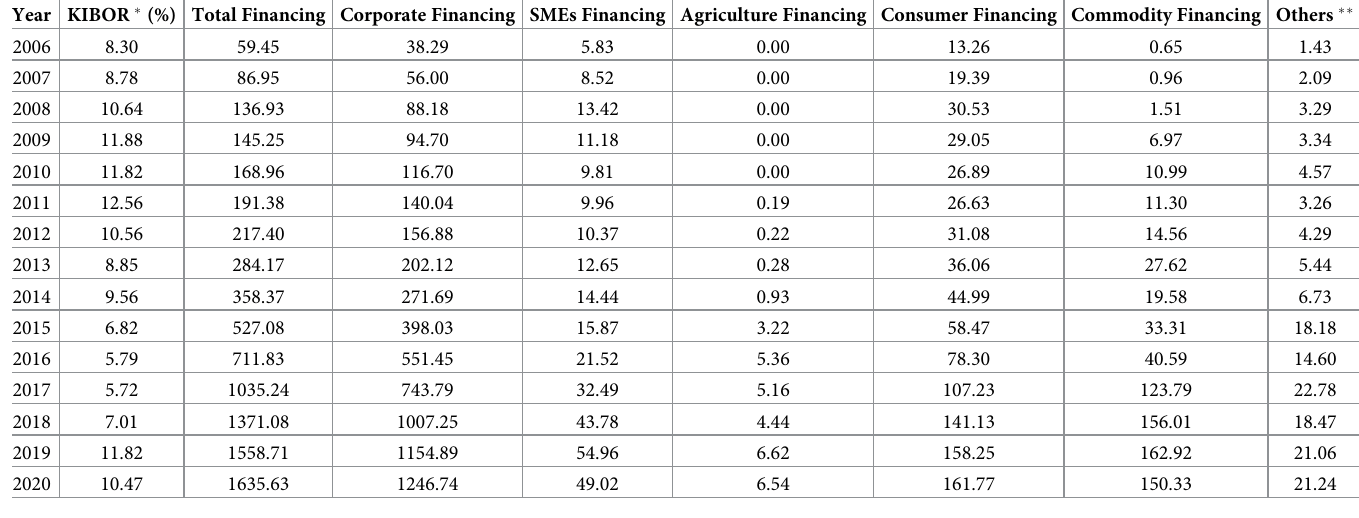
Table 1. Annual averages (average annual financing of overall industry in billion